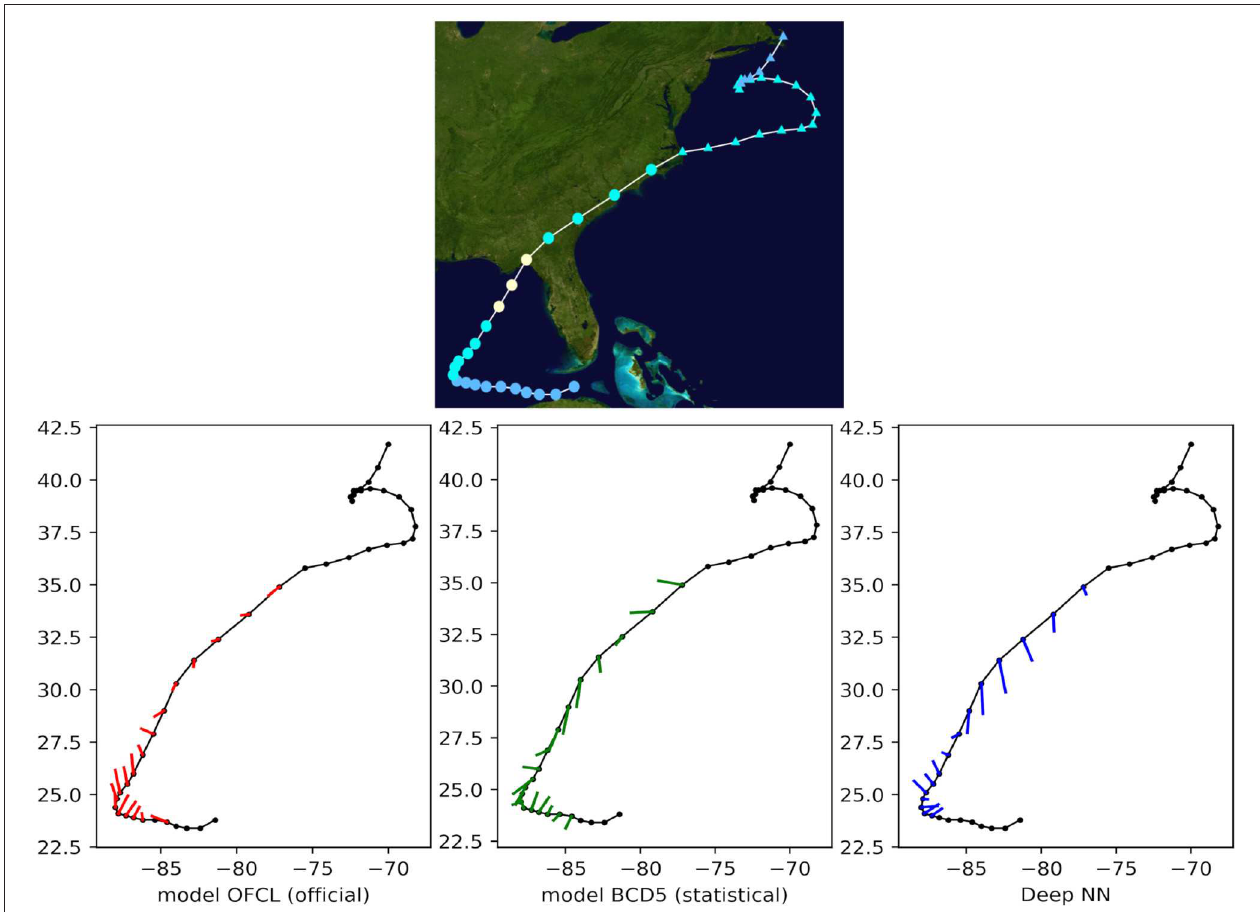
FIGURE 10 | 24-h forecast errors (4 time steps ahead) on Tropical Cyclone Hermine in 2016. The bars connect each pair of predicted and ground truth location. The longer the length, the larger the error. At the beginning and at the end of the track, the forecasts were not always available (a complete absence of an error bar should be interpreted as no forecast